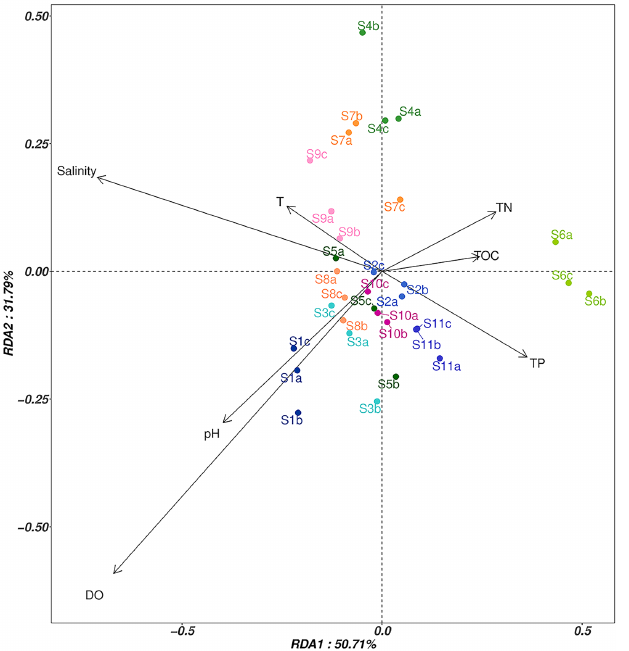
Figure 4. RDA analysis of fungal community structure and environmental factors at 11 coastal sites (S1–S11). Three replicates (e.g., S1a, S1b, S1c) were collected from each site. (S1–S11). Three replicates (e.g., S1a, S1b, S1c) were collected from each